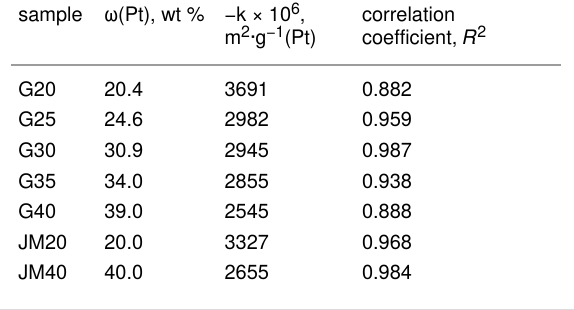
Table 4: Coefficients of the slope angle formed by the straight line dependencies "ESA as a function of the cycle number" and the corre- lation parameters of the linear dependence